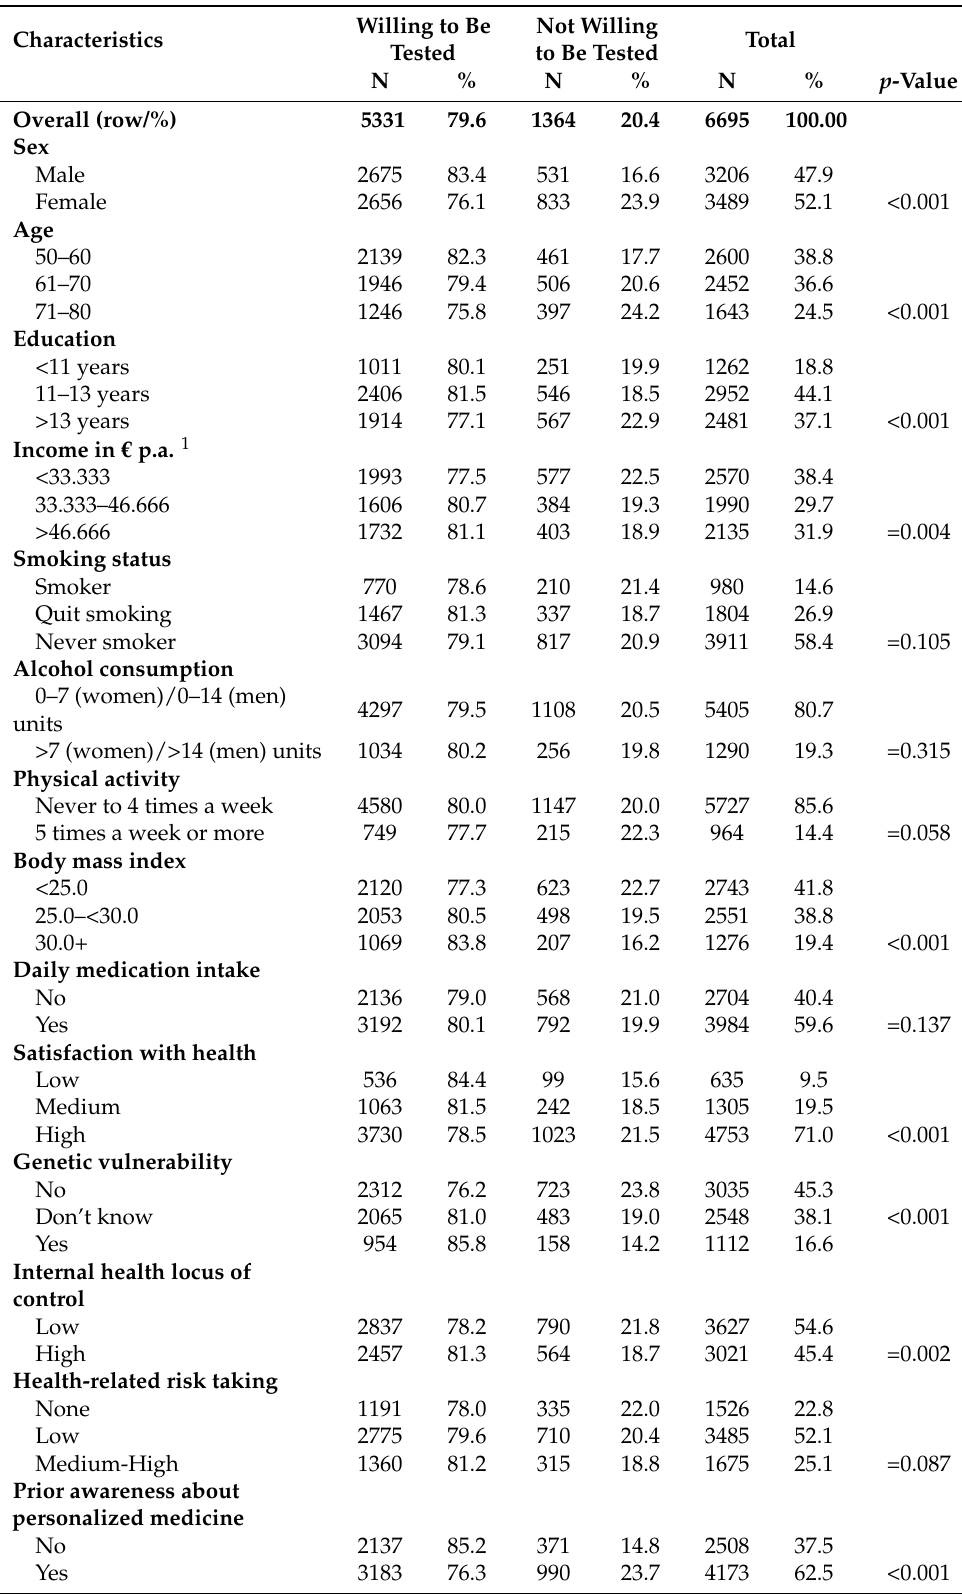
Table 2. Bivariate associations between sample characteristics and readiness to accept a genetic test for personalized